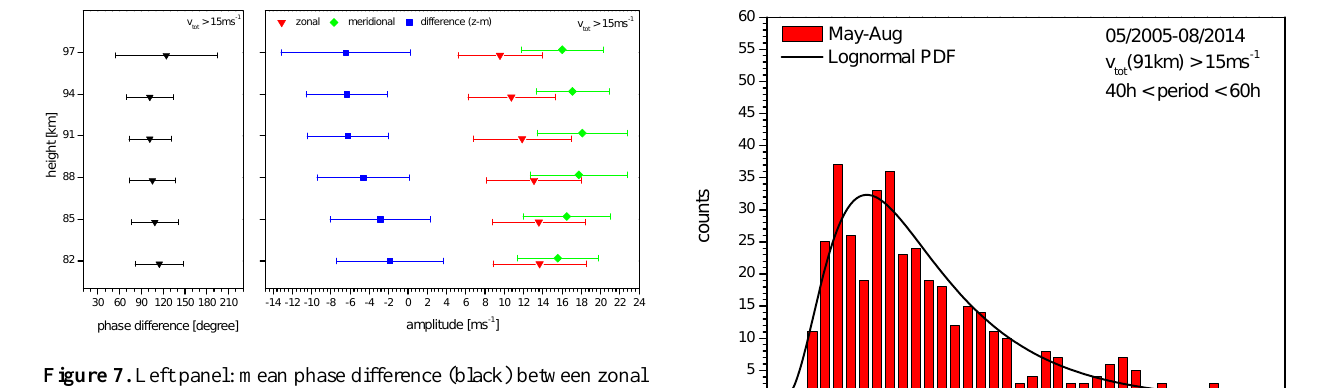
Figure 7. Left panel: mean phase difference (black) between zonal and meridional components for 2004–2014 and their standard devi- ations. Right panel: zonal (red) and meridional (green) mean ampli- tudes for 2004–2014 and their standard deviations. Amplitude dif- ference with standard deviation in blue. For both panels only dates with total amplitude > 15ms − 1 are used.